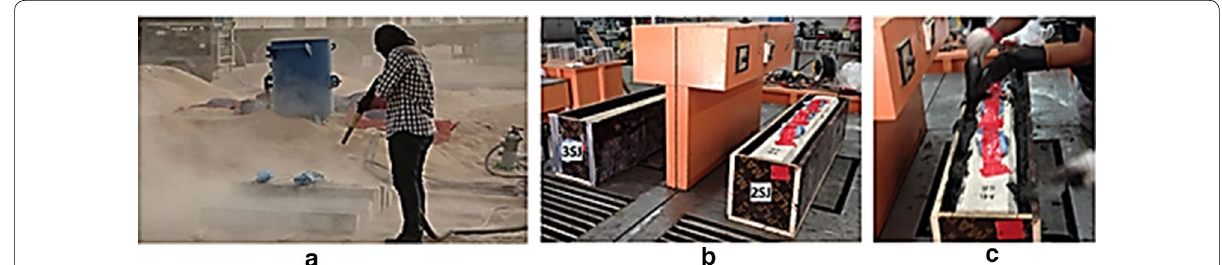
Fig. 5 a Applying sandblasting, b placing sandblasted RC beam in mold, c casting UHPC directly on the RC beams.